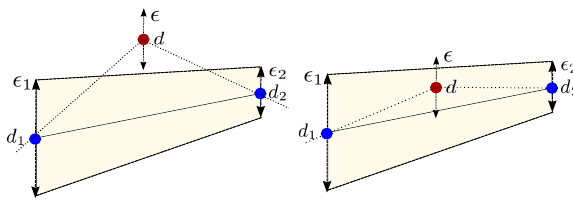
Figure 2: Visualization of the error criterion, point candidate red, dependent node points blue. Left: error criteria is not fulfilled, point candidate is inserted to triangulation. Right: error criteria is fulfilled, point candidate is not inserted to triangulation.